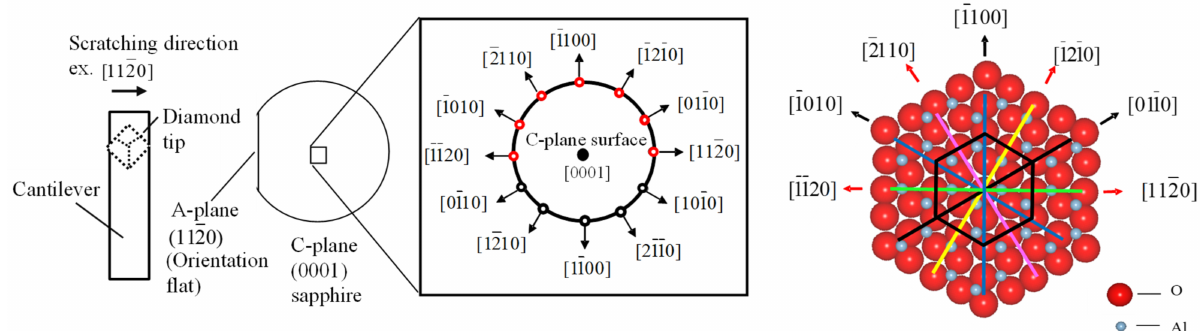
Figure 4. Schematic of defined nanoscratch directions on c-plane